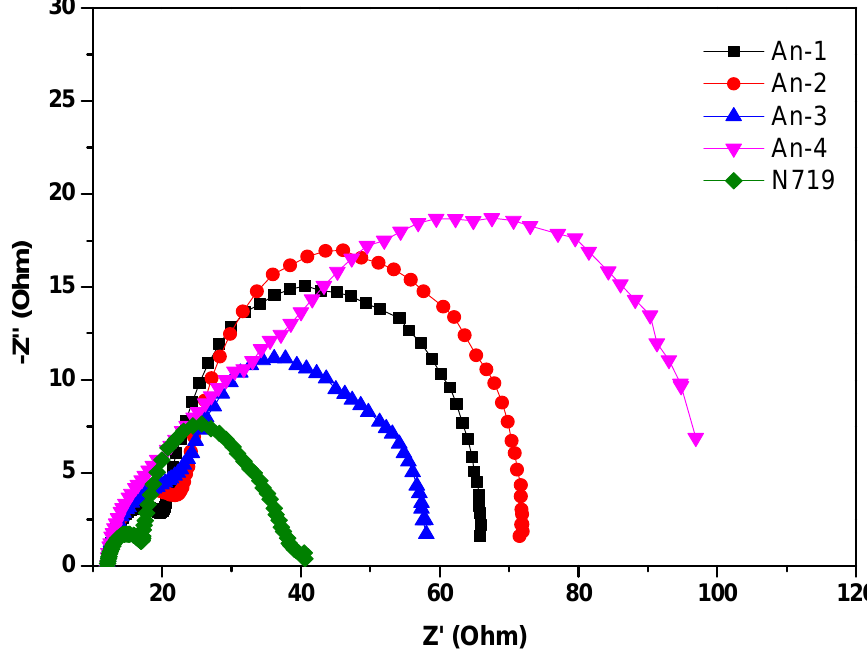
Figure 7. Electrochemical impedance spectra (Nyquist plots) of DSSC for dyes measured under illumination (AM 1.5).